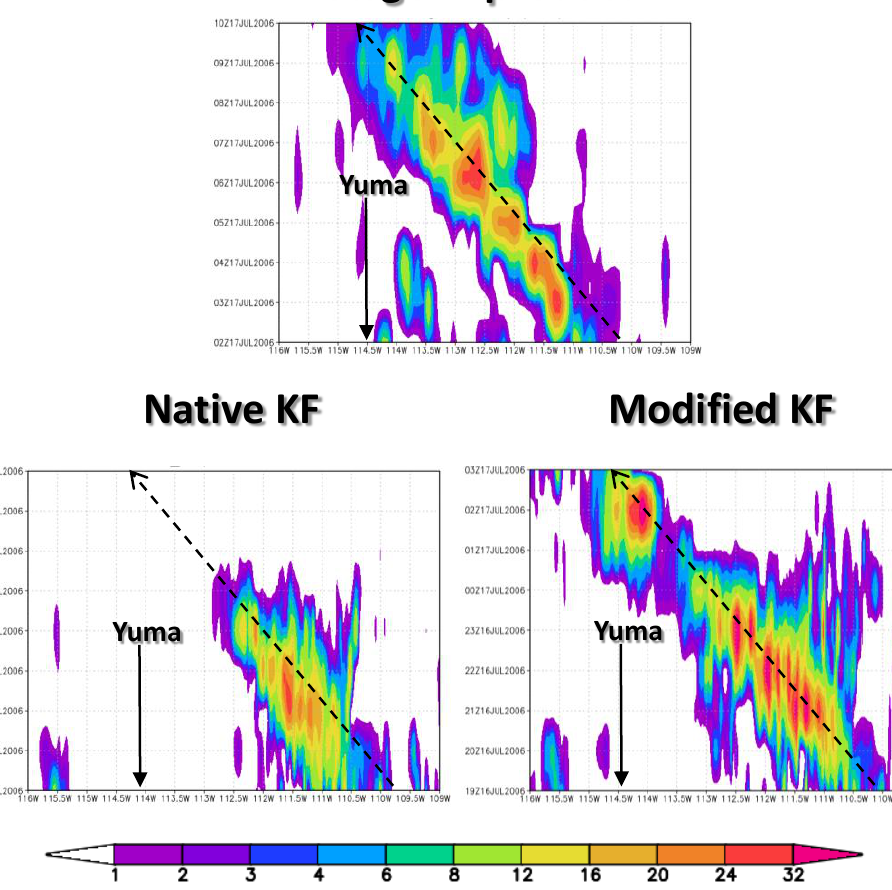
Figure 15. Hovmöller diagrams of hourly precipitation (mm) of a MCS-type monsoon thunderstorm propagating West-Northwesterly toward Yuma, Arizona, on July 16th 2006 for Stage IV product ( top ) and WRF simulations on convective-permitting domain 3 (2.5 km) with native KF ( bottom left ) and modified KF ( bottom right ).